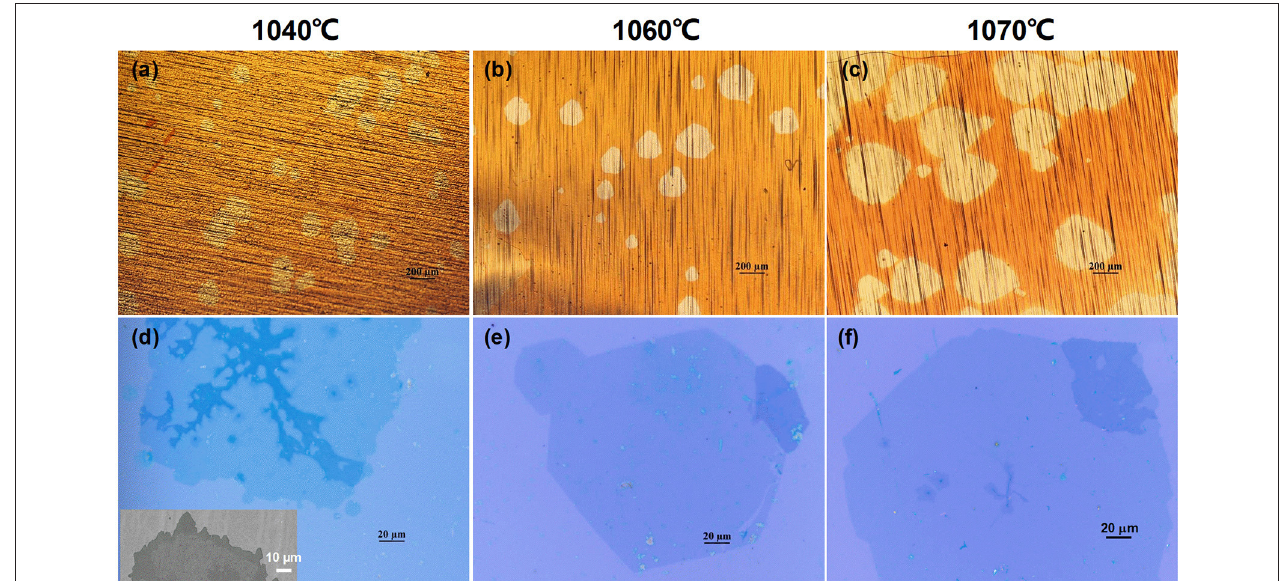
FIGURE 6 | Optical images of the obtained graphene domains prepared with different growth time. (a,d) 1040 ◦ C, (b,e) 1060 ◦ C, (c,f) 1070 ◦ C. Inset in (d) is the SEM image of the dendritic domain